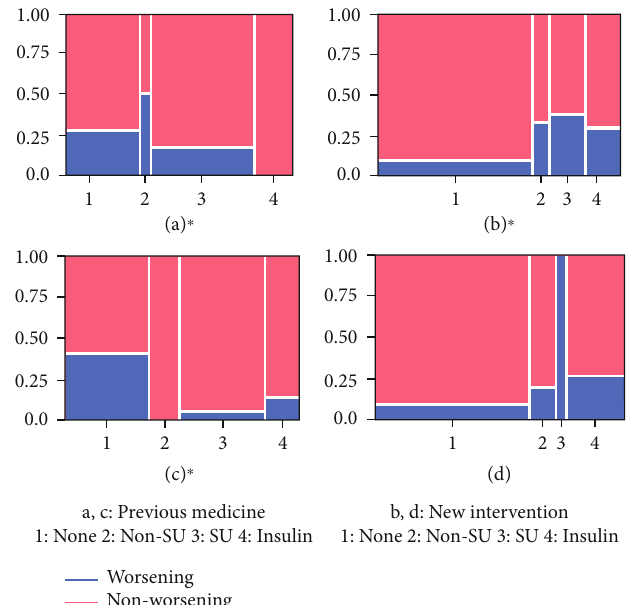
Figure 1: Rates of previous medication and new interventions in a patient with simple diabetic retinopathy (a, b) and preproliferative diabetic retinopathy (c, d). Cochran – Armitage trend test was performed, with p < 0 : 05 indicating statistical signi fi cance ( ∗ ). The X -axis classi fi es patients into four categories: none (1), nonsulfonylurea (2), sulfonylurea (3), or insulin (4). The width represents the number of patients classi fi ed. The Y -axis indicates the number of patients classi fi ed into two categories: worsening (blue) or nonworsening (red). Among patients with SDR, those who received no previous medication tended to have worsening retinopathy (a). New intervention tended to signi fi cantly intensify in worsening patients with SDR (b). Among patients with PPDR, those who received no previous medication tended to have worsening retinopathy